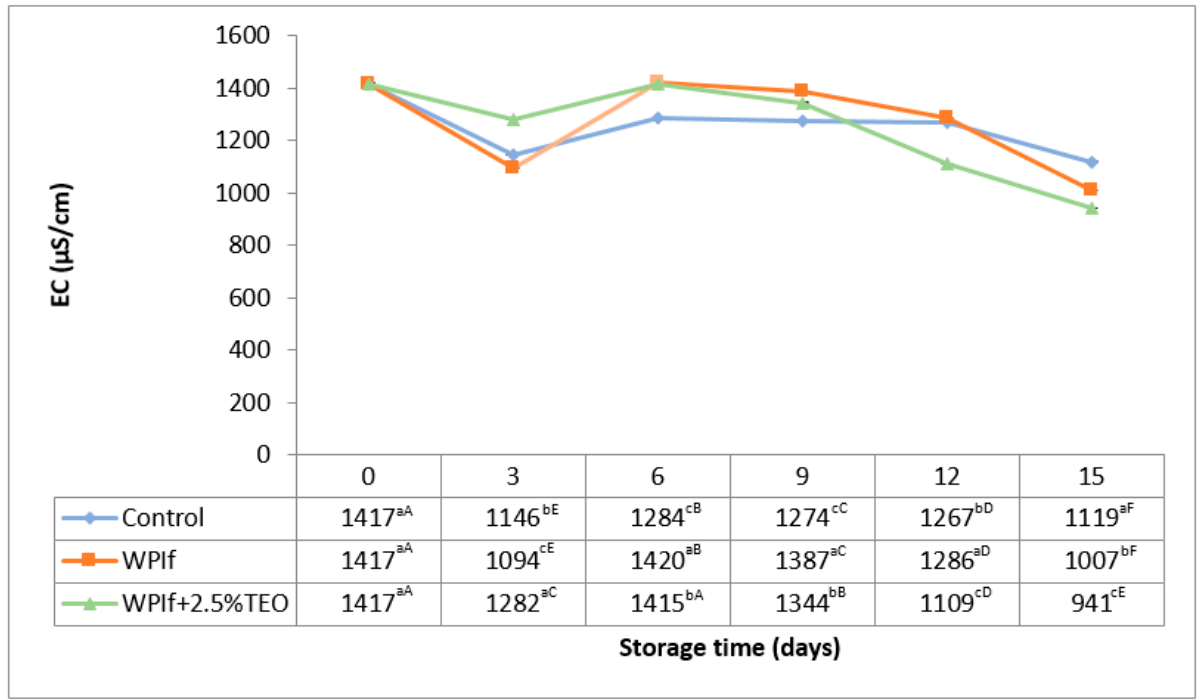
Figure 2. Changes in electrical conductivity (EC) of brook trout samples during refrigerated storage. Control-uncovered fish samples; WPIf-fish samples covered with WPI-based films; WPIf+2.5%TEO-fish samples covered with whey protein isolate-based films incorporated with 2.5% tarragon essential oil. Values are expressed as mean ± standard deviation of two replicates. Means that do not share a letter (lowercase letters on column and uppercase letters on row) are significantly different.